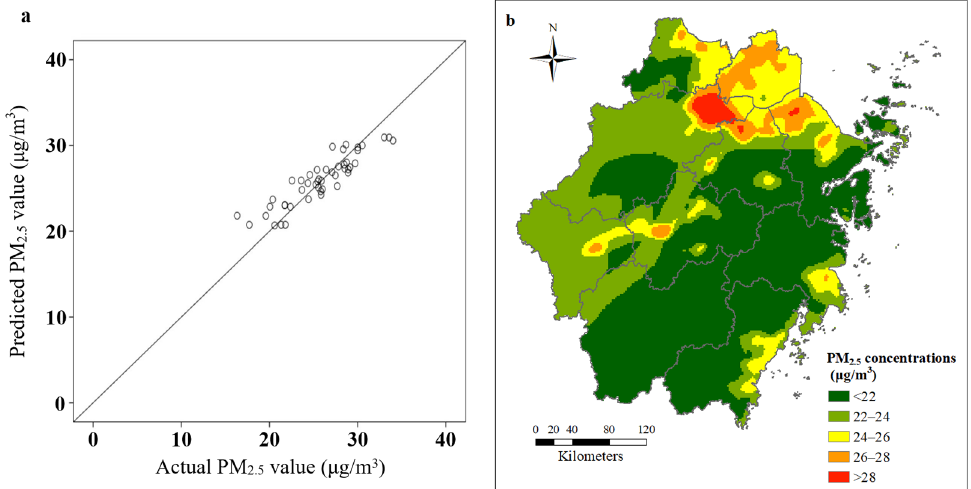
Figure 6. ( a ) The predicted and actual values of the random forest model. ( b ) Simulation results of the random forest-based improved LUR model.